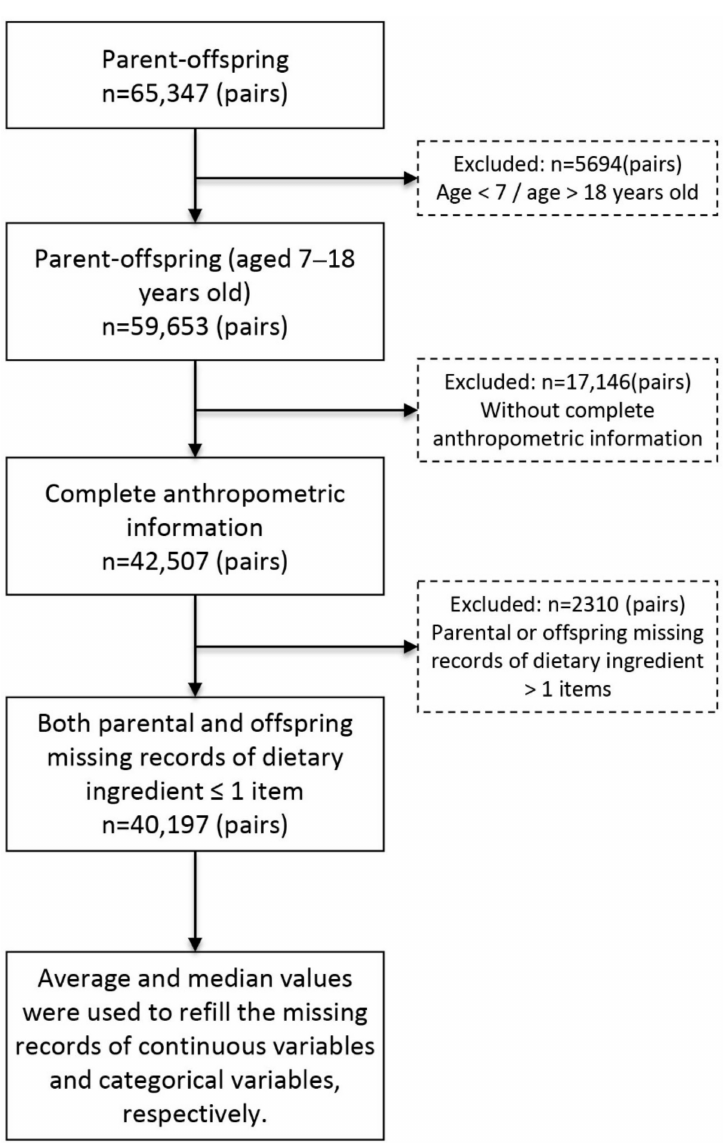
Figure 1. The selection process of the